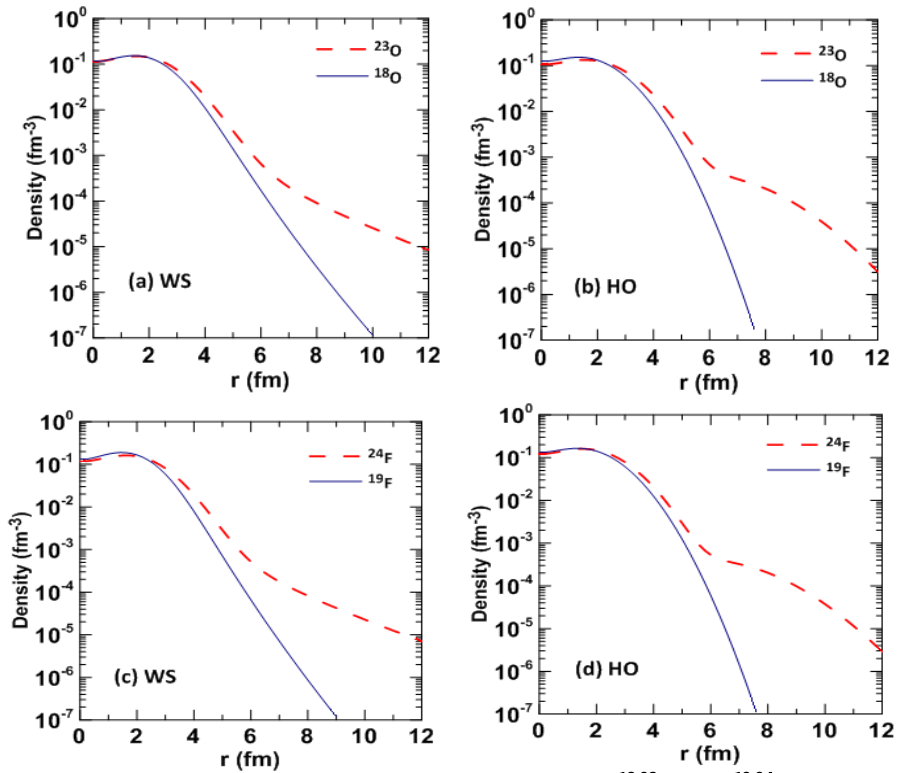
Fig. 3: Calculated matter densities for nuclei 18,23 O and 19,24